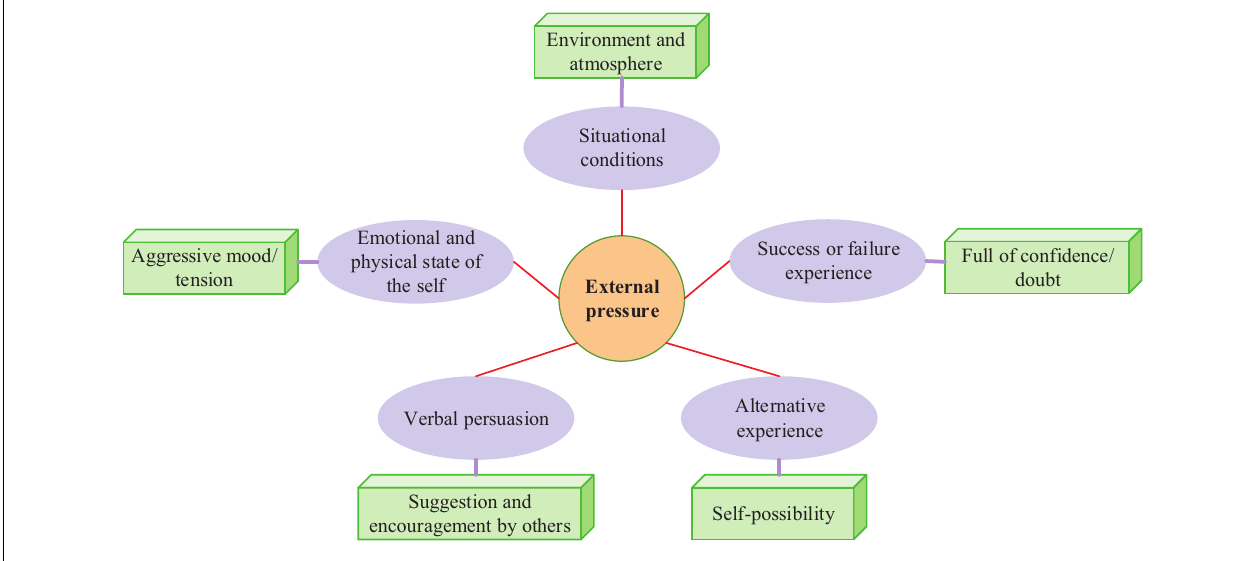
FIGURE 3 | Five types of influencing factors of self-efficacy.